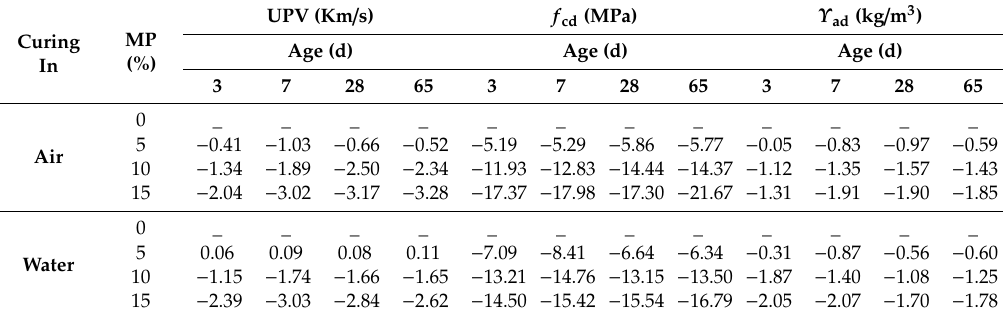
Table 5. The increase / decrease rate of compressive strength, UPV, and apparent density of mortar containing